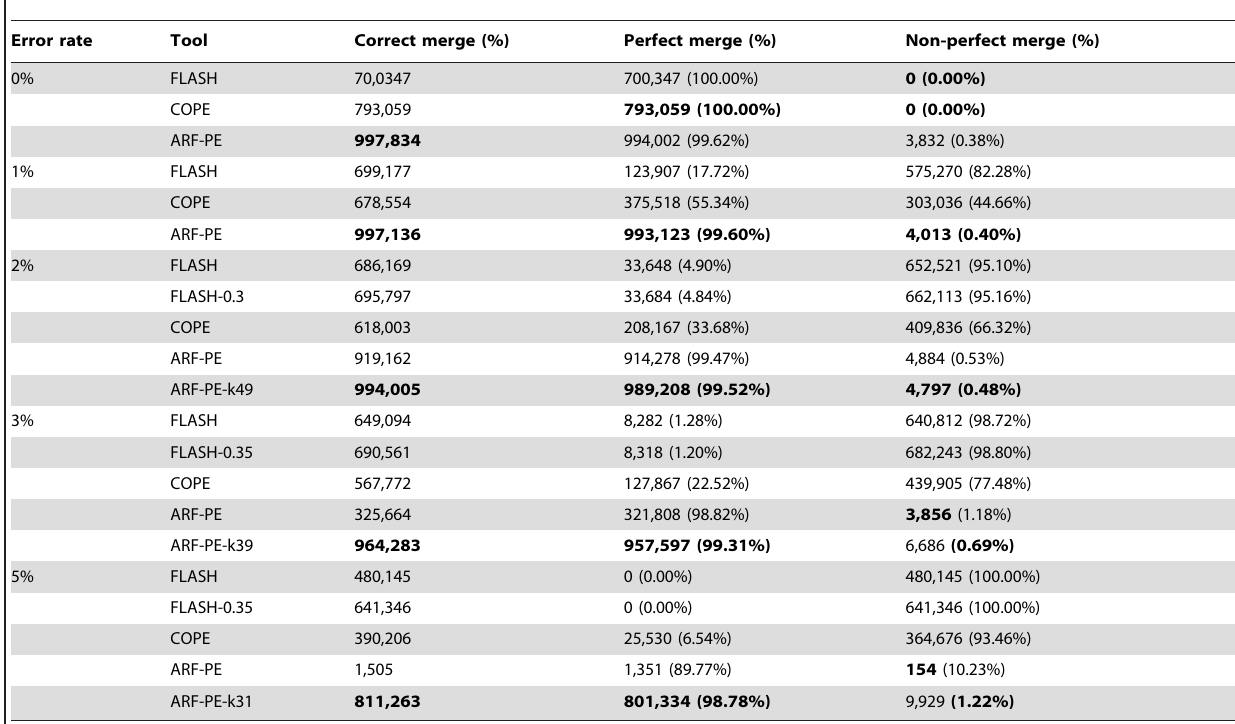
Table 3. Percentage of perfect DNA fragment recoveries by FLASH, COPE, and ARF-PE.